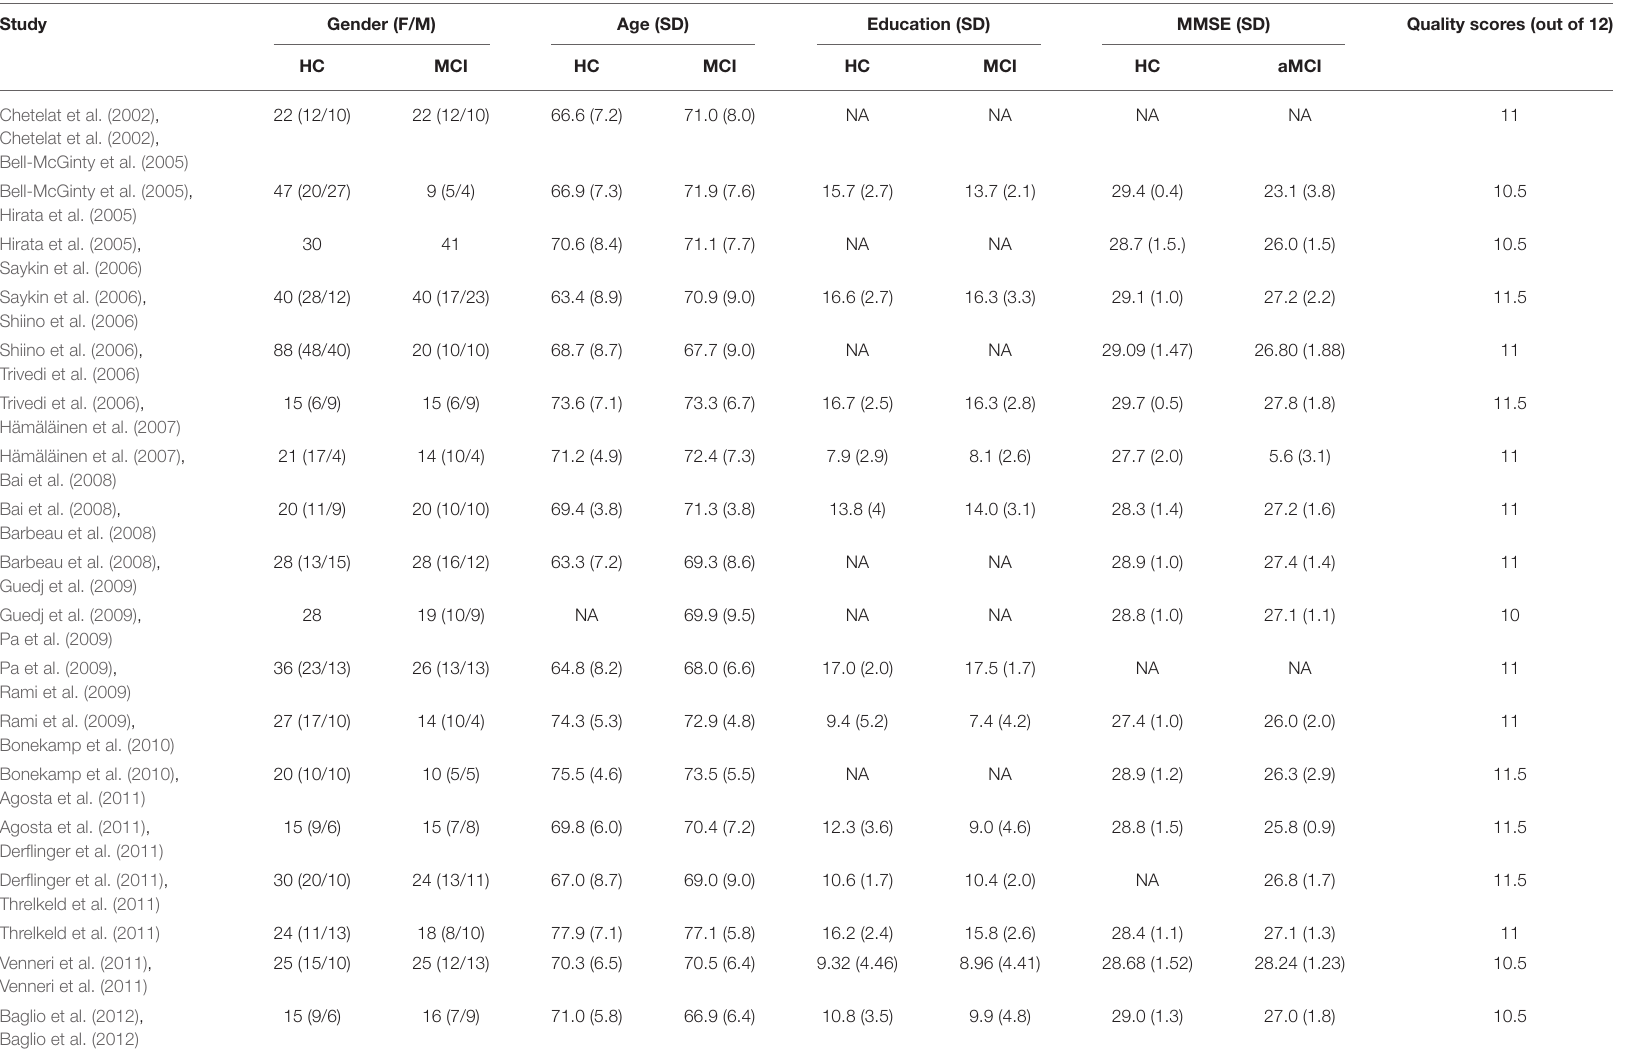
TABLE 1 | Demographic and clinical characteristics of the included VBM studies.